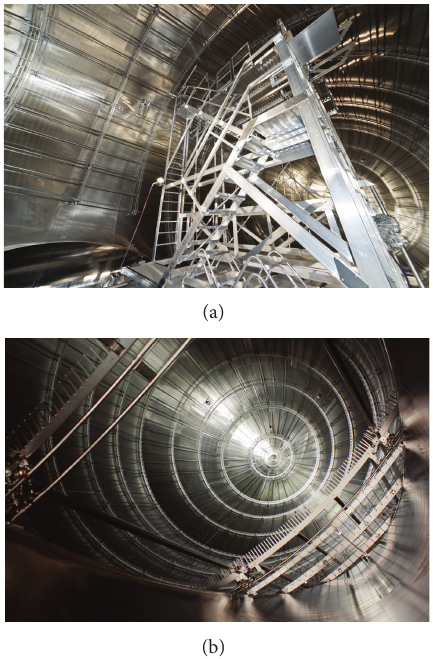
Figure 23: Photographs of the oil- and dust-free scaffold to install the wire electrode system in the main spectrometer (a) and view into the main spectrometer before the last two wire electrode modules at one of the pump ports were installed to finish the wire electrode installation (b). Photographs: Michael